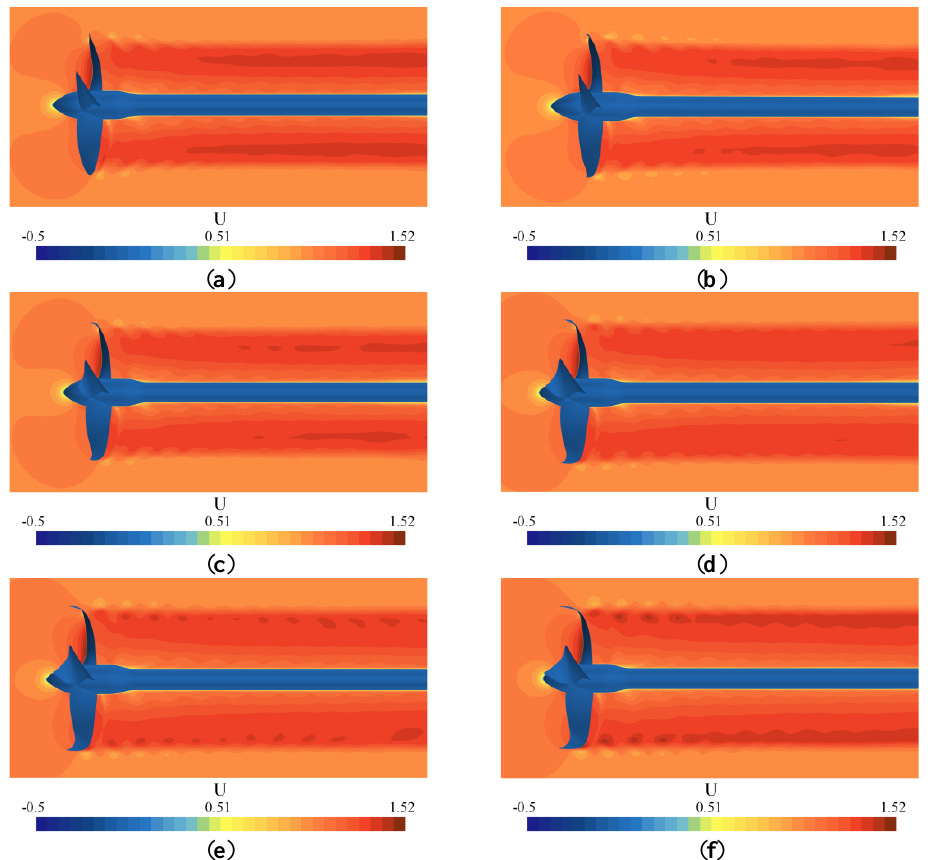
Figure 16. Dimensionless axial velocity distribution of propeller Kap00 ( a ), Kap01 ( b ), Kap02 ( c ), Kap03 ( d ), Kap04 ( e ) and Kap05 ( f ) ( J = 0.8, 12 rps, and σ = 2.0).